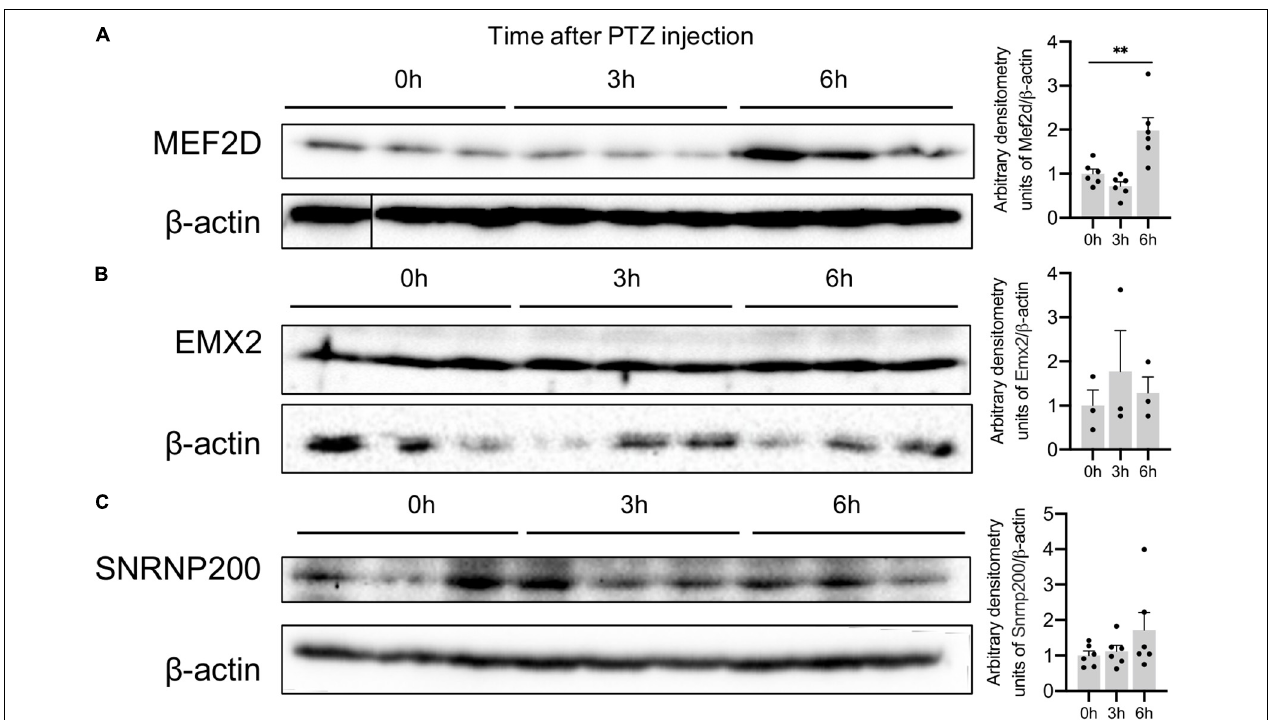
FIGURE 6 | Protein expression of Plaur-miR1 (Plaur-miR1-3p and Plaur-miR1-5p) target genes Mef2d , Snrnp200, and Emx2 in mouse striatum. Western blot analysis of (A) MEF2D, (B) SNRNP200 and (C) EMX2 expression in striatum of control mice (treated with saline, 0 h) and of mice after 3 and 6 h induction of endogenous Plaur expression. Densitometric analyses and values of protein expression normalized to β -actin are presented as mean ± SEM ( n = 3–6). The vertical line in (A) indicates where the WB lanes were cut and the lanes of the same immunoblot were placed together to allow for a direct comparison. The data were analyzed using analysis of variance followed by Dunnett’s multiple comparisons test with GraphPad Prism software. Statistical significance is indicated by bars and asterisks as follows: ∗∗ p <